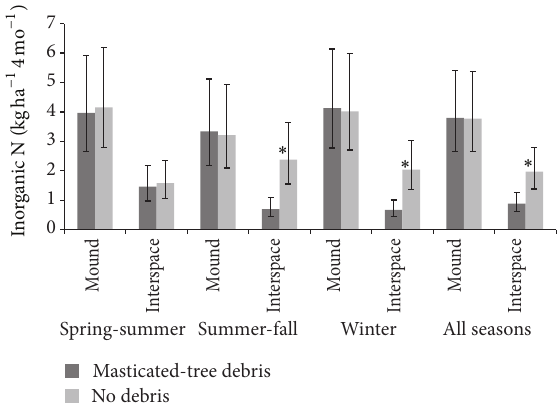
Figure 5: Masticated-tree debris effects on inorganic N (NO 3− + NH 4+ ) derived from ion exchange membranes in intact tree mounds and interspaces between trees. Asterisks indicate dif- ferences between column pairs ( 𝑃 < 0.01 ). Winter includes November–February, spring-summer includes March–June, and summer-fall includes July–October. Error bars are 95% confidence